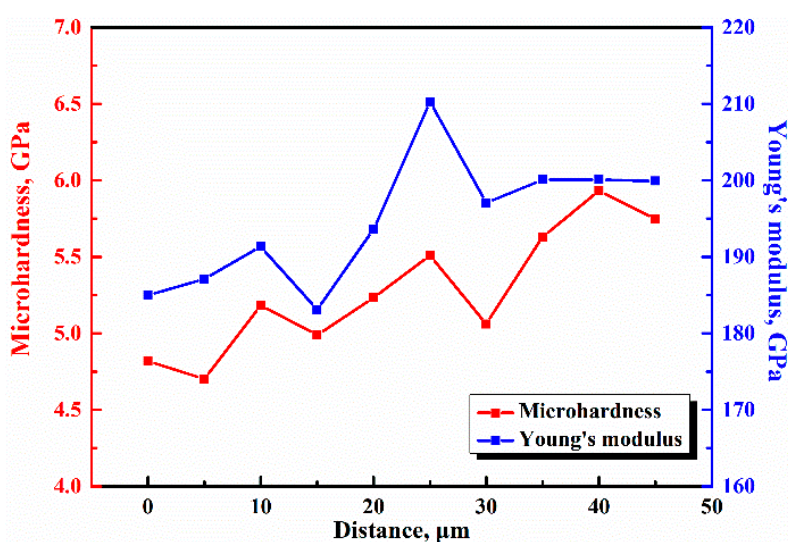
Figure 6. The nanoindentation result of joint bonded by 1150 °C-5MPa-1h.